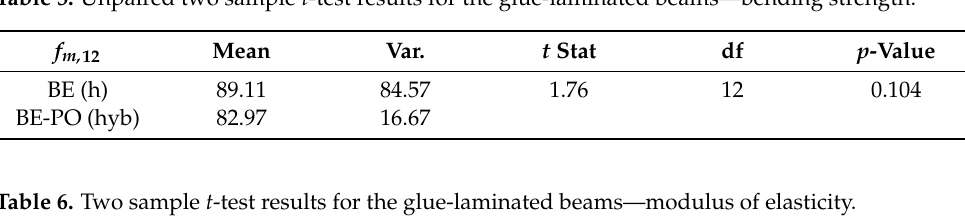
Table 6. Two sample t -test results for the glue-laminated beams—modulus of elasticity. E m,l, 12 Mean Var.